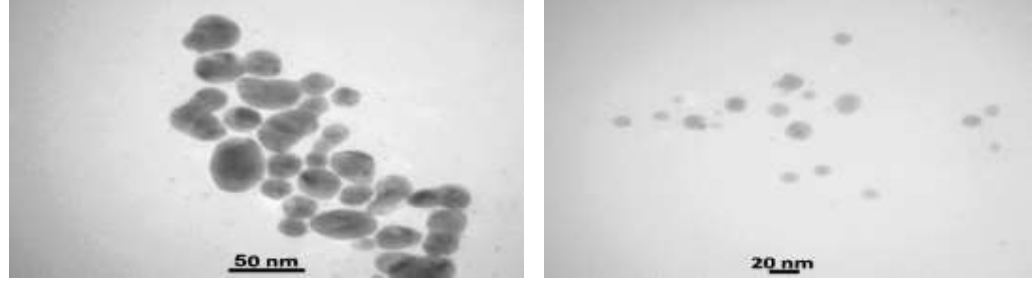
Figure 5: TEM images of chemically reduced silver